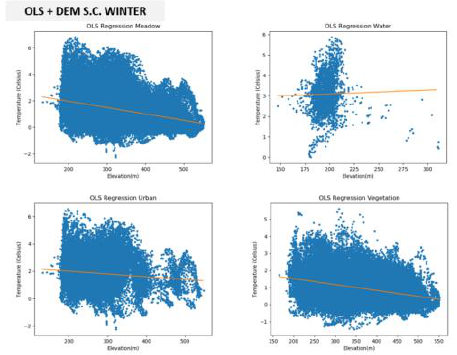
Figure 25: OLS Regression Model in Winter (Temperature – Land Cover - DEM)